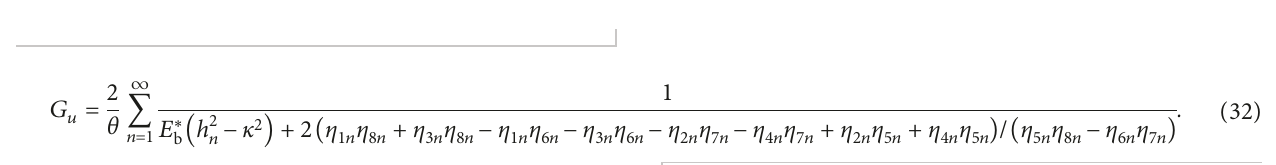
shown in Figure 3. The nondimensional time ������ 􏽰 τ � t μ / ρ / a , where t denotes the time, a denotes the sm0 radius of the pile, and ρ and μ denote the density and sm0 shear modulus of the unfrozen saturated soil,